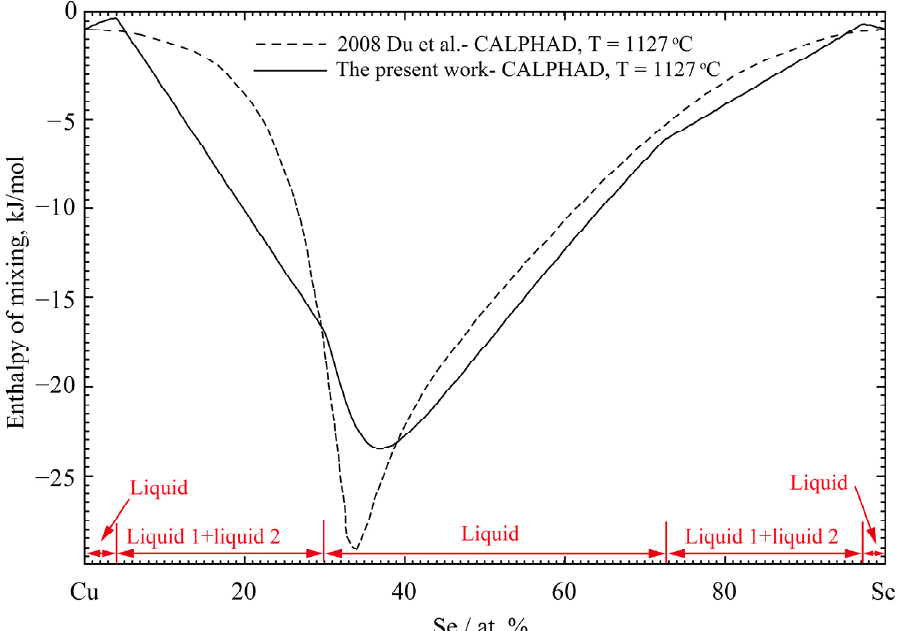
Figure 9. The calculated standard entropy of formation at 25 °C in the Cu-Se system compared with the experimental data from refs. [93–95] and previously optimized results by Du et al. [100].